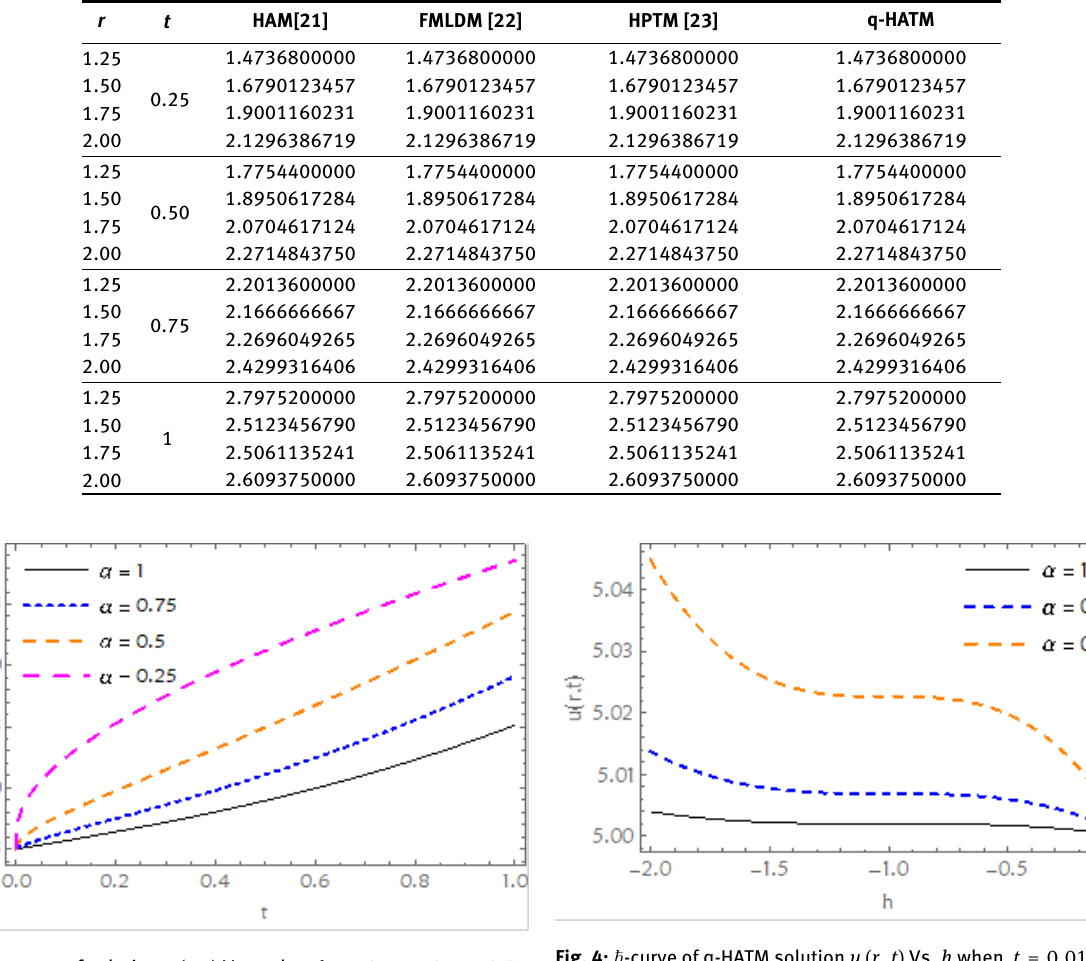
Fig. 2: α -curve of solution u ( r , t ) Vs. t when (cid:126) = −1, n = 1, r = 1.5 for Ex. 4.1